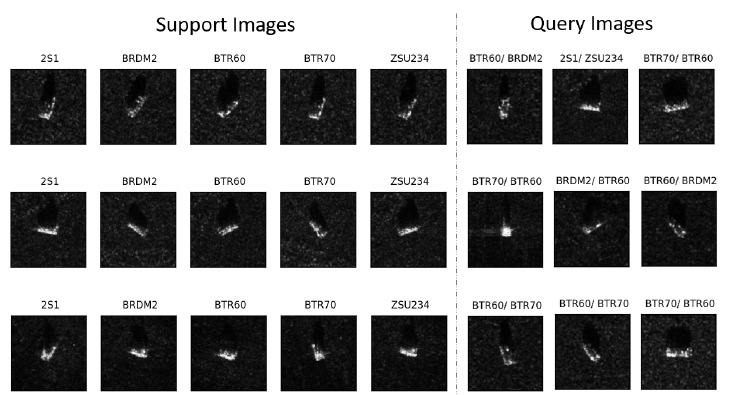
Figure 10. Typical incorrect predictions of IAT under the 1 shot setting. The support images are placed on the left with their corresponding classes. The incorrectly predicted query images are placed on the right and the fonts are in the format of (ground truth class/predicted